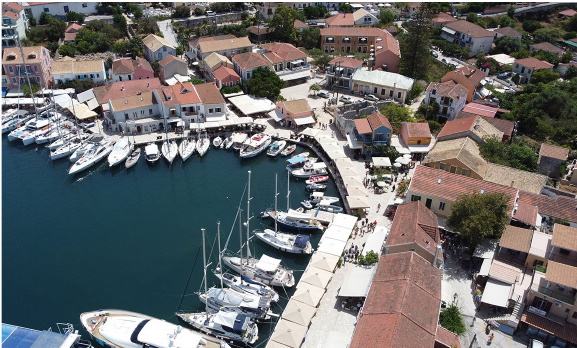
Figure 4 . Fiskardo Port, drone photo, bird's eye view, southern view.